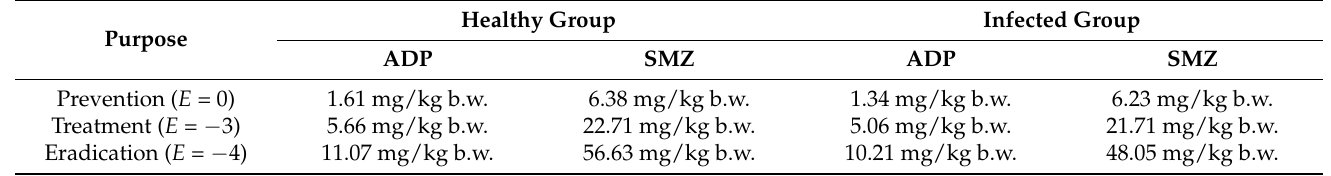
Table 8. Dosage of ADP/SMZ injection for different drug